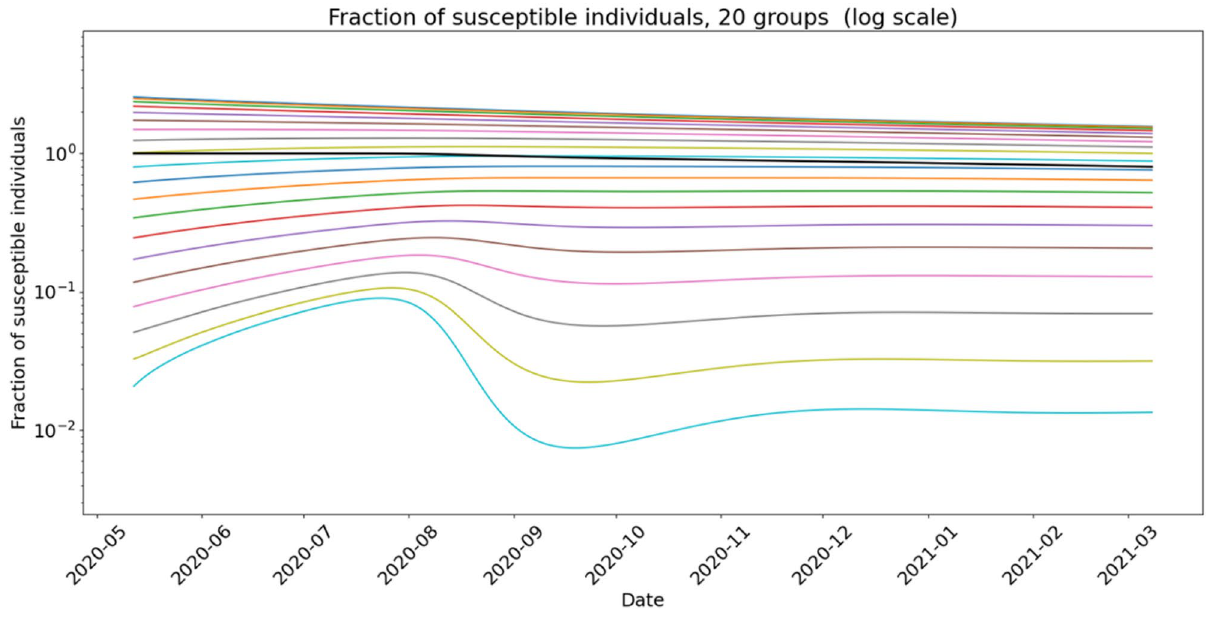
Figure 6. Calibrated model on Sète WWTP: density of susceptible individuals of each group for n g = 20 . The densities of susceptible of each group is represented in colour curves as functions of time. The curves are ordered from top to bottom according to increasing a . The resulting average total susceptible population is represented in black. Susceptible individuals of highest a trait, which are represented in the bottom light blue curve exhibit a non monotonic